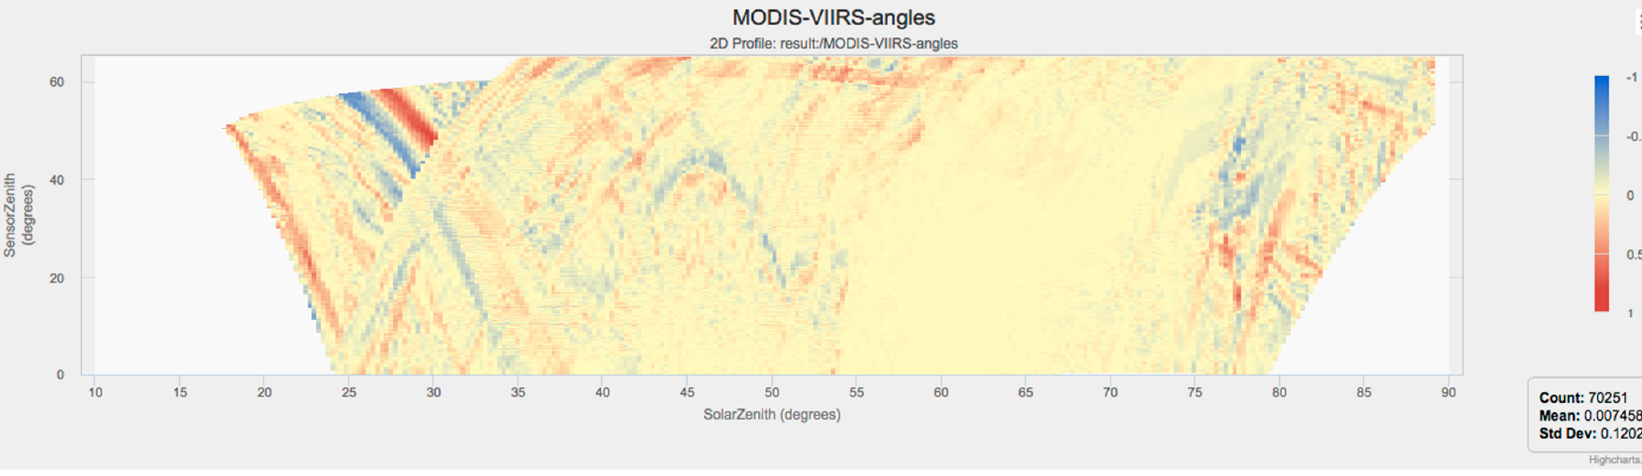
Figure 12. Mixed scene (ice, clouds, ocean) over Antarctica showing reflectance from VIIRS ( top ) and MODIS ( middle ) plotted against the solar zenith angle (x-axis) and viewing zenith (y-axis). For this scene the average reflectance difference is 0.0014 (0.29% of the average scene reflectance). The difference plot shows the average reflectance difference of 0.0075 (1.56%) for grid cells based on the viewing zenith and solar zenith angles.